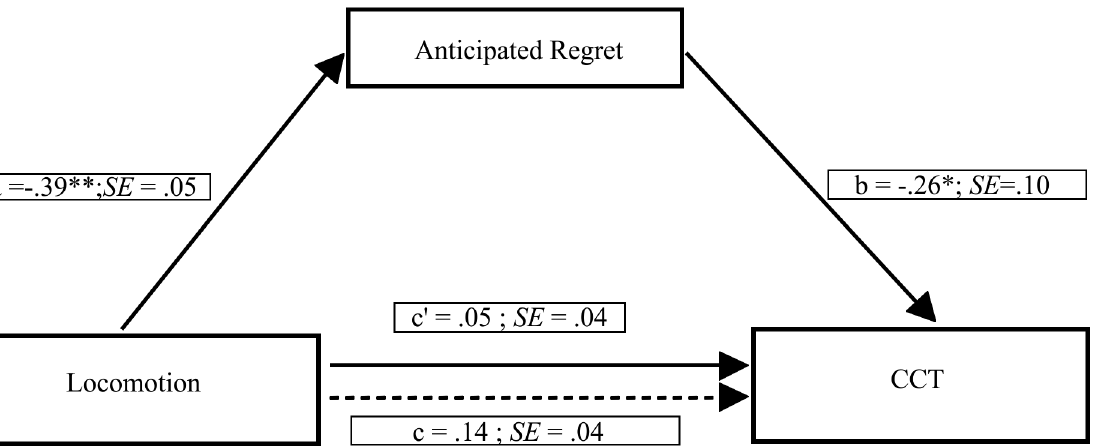
Fig 5. Mediation model showing the effect of the locomotion orientation on risk-taking through anticipated regret. Path values represent standardized regression coefficients. The (c') value represents the effect, from bootstrapping analyses, of the locomotion orientation on risk-taking after the mediator is included. Dotted line (c) represents the effect of the locomotion orientation on risk-taking prior to the inclusion of anticipated regret. * p < .05; ** p <